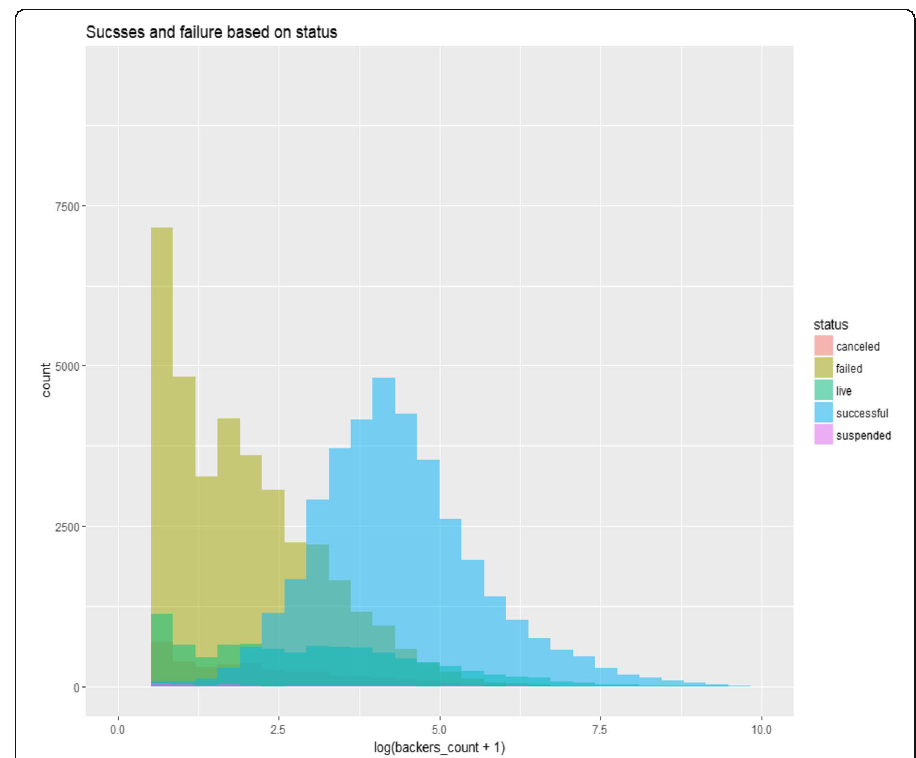
Fig. 6 Histograms of backers count based on